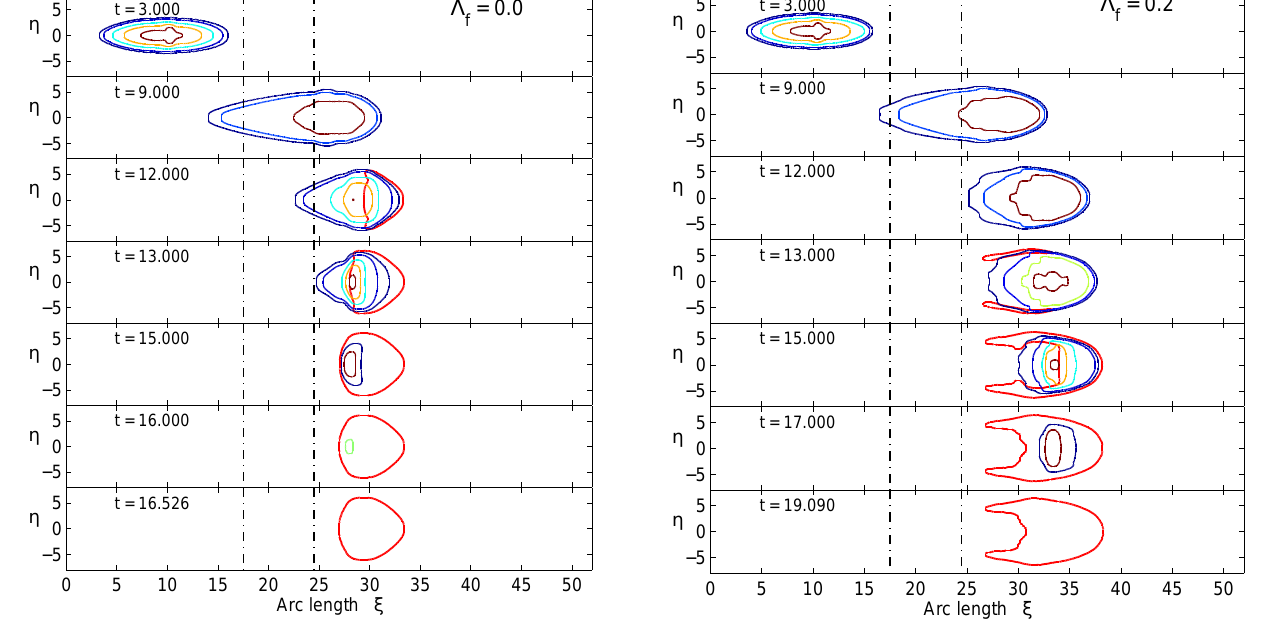
Fig. 5. Contour plots of the flowing mass and the evolution of the deposition heap, where Λ f =0 . 2 with the deposition procedure be- ing adopted in the computation.